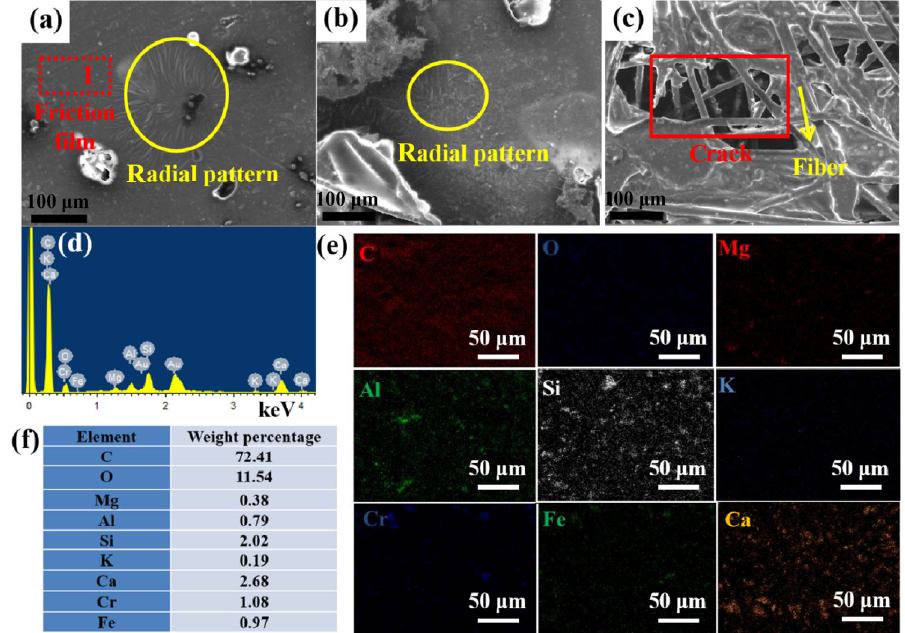
Fig. 10 SEM images of different samples: (a) S1, (b) S2, and (c) S3 after wear, (d) EDS spectroscopy, (e) elemental mapping, and (f) elemental weight percentage of worn surface for area 1 of S1 .